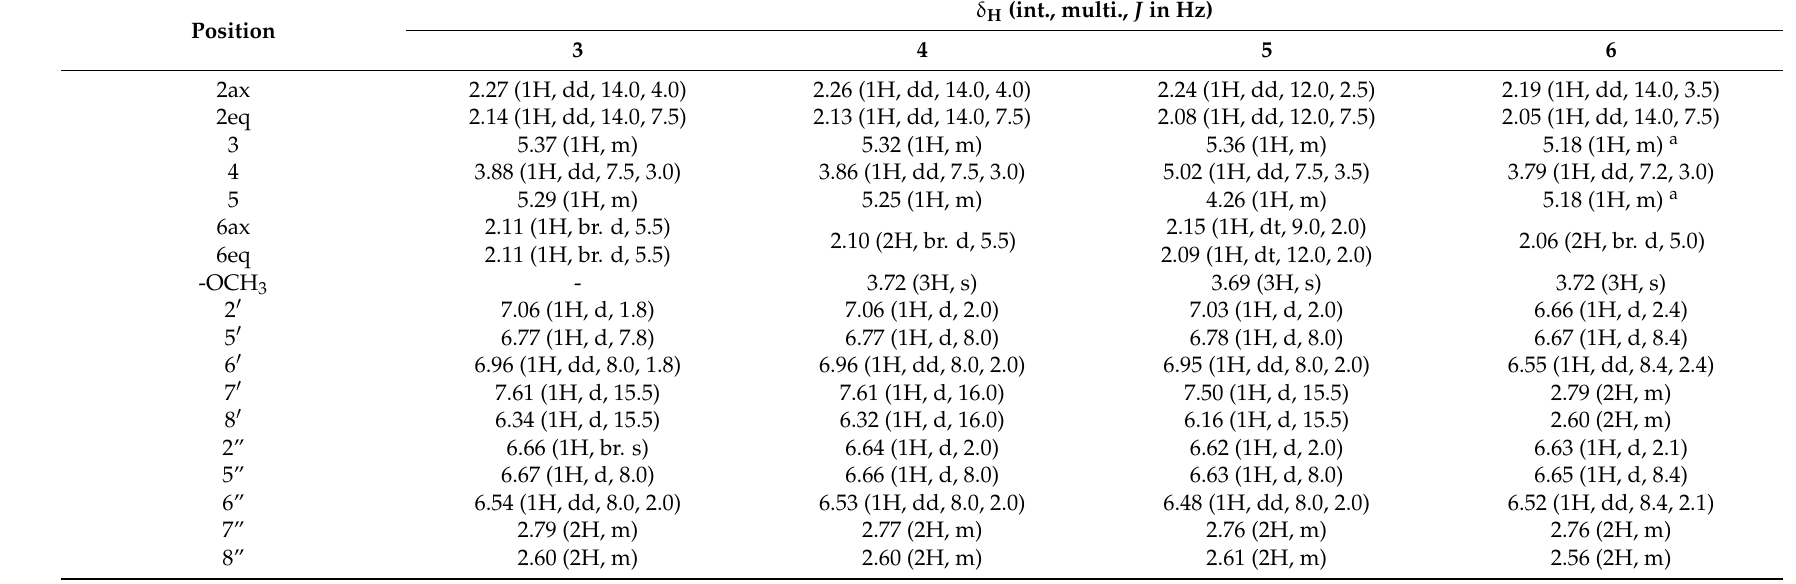
Table 1. 1 H-NMR (500 MHz) data for 3 – 6 in CD 3